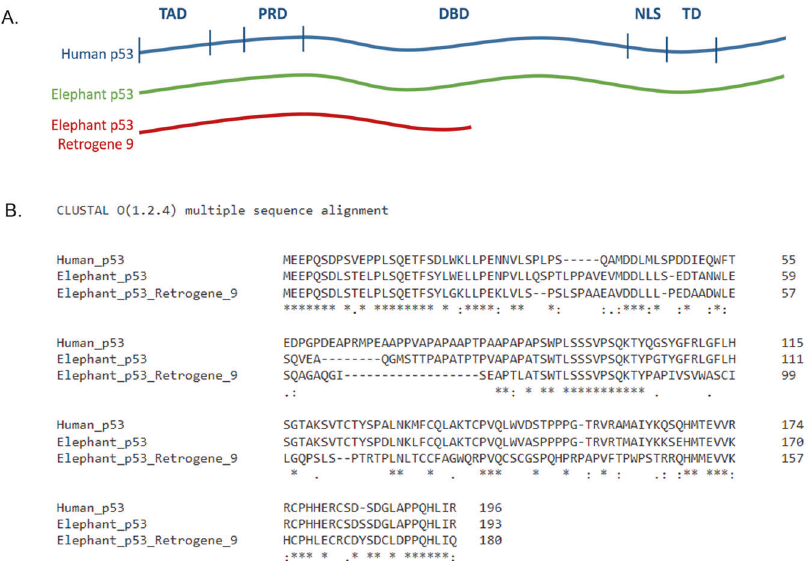
Fig. 1 Elephant p53-Retrogene 9 encodes a truncated version of full-length elephant or human p53. A Cartoon of human p53, elephant p53, and elephant p53 retrogene 9, showing protein lengths and alignment of p53-R9 to known domains of human p53. TAD Transactivation Domain, PRD Proline-Rich Domain, DBD DNA Binding Domain, NLS Nuclear Localization Sequence, TD Tetramerization Domain. B Clustal multiple sequence alignment of human p53, elephant p53, and elephant-p53-retrogene 9 is shown up to the stop codon in p53-retrogene